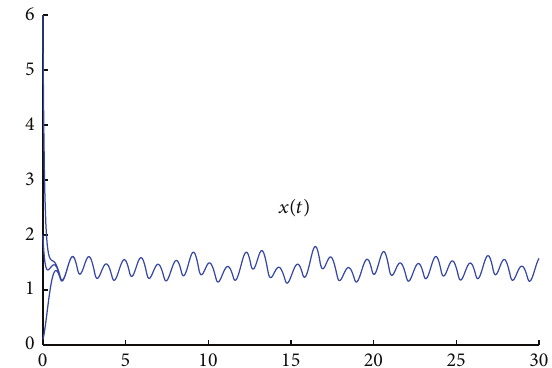
Figure 1: Numerical solution 𝑥(𝑡) of system (51) for initial value 𝜑(𝑡) ≡ 0.1, 2,6